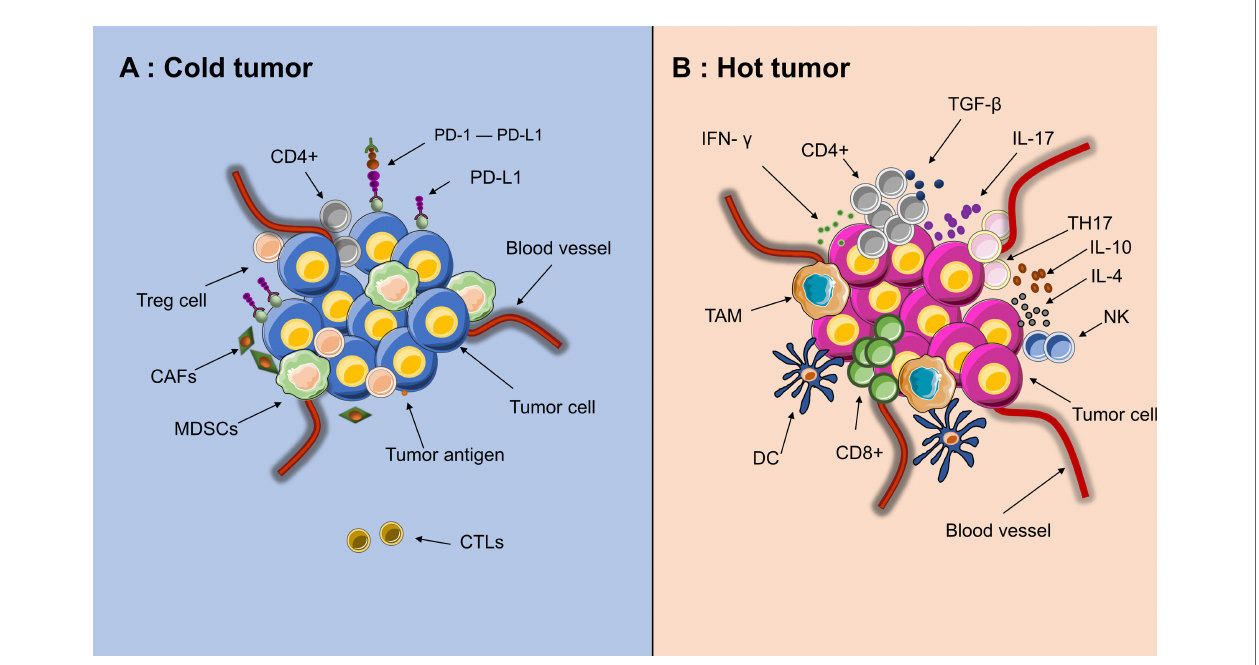
FIGURE 3 | Tumor microenvironment of “ hot ” and “ cold ” cancer. (A) High activities of effector immune cells, such as CD8+ effector T cells, tumor-associated macrophages (TAM), dendritic cells (DC), IL+17 T cells (TH17) and CD4+ activated T cells. (B) High activities of Myeloid-derived suppressor cells (MDSCs), Tregs and CAFs, low activities of CTLs(CD8+)and few recruitment of dendritic cells(DCs). Since the edge of the tumor is in a state of chronic hypoxia, immune cells could migrate from the edge toward the center of tumor, making the core of tumor immunologically hot.